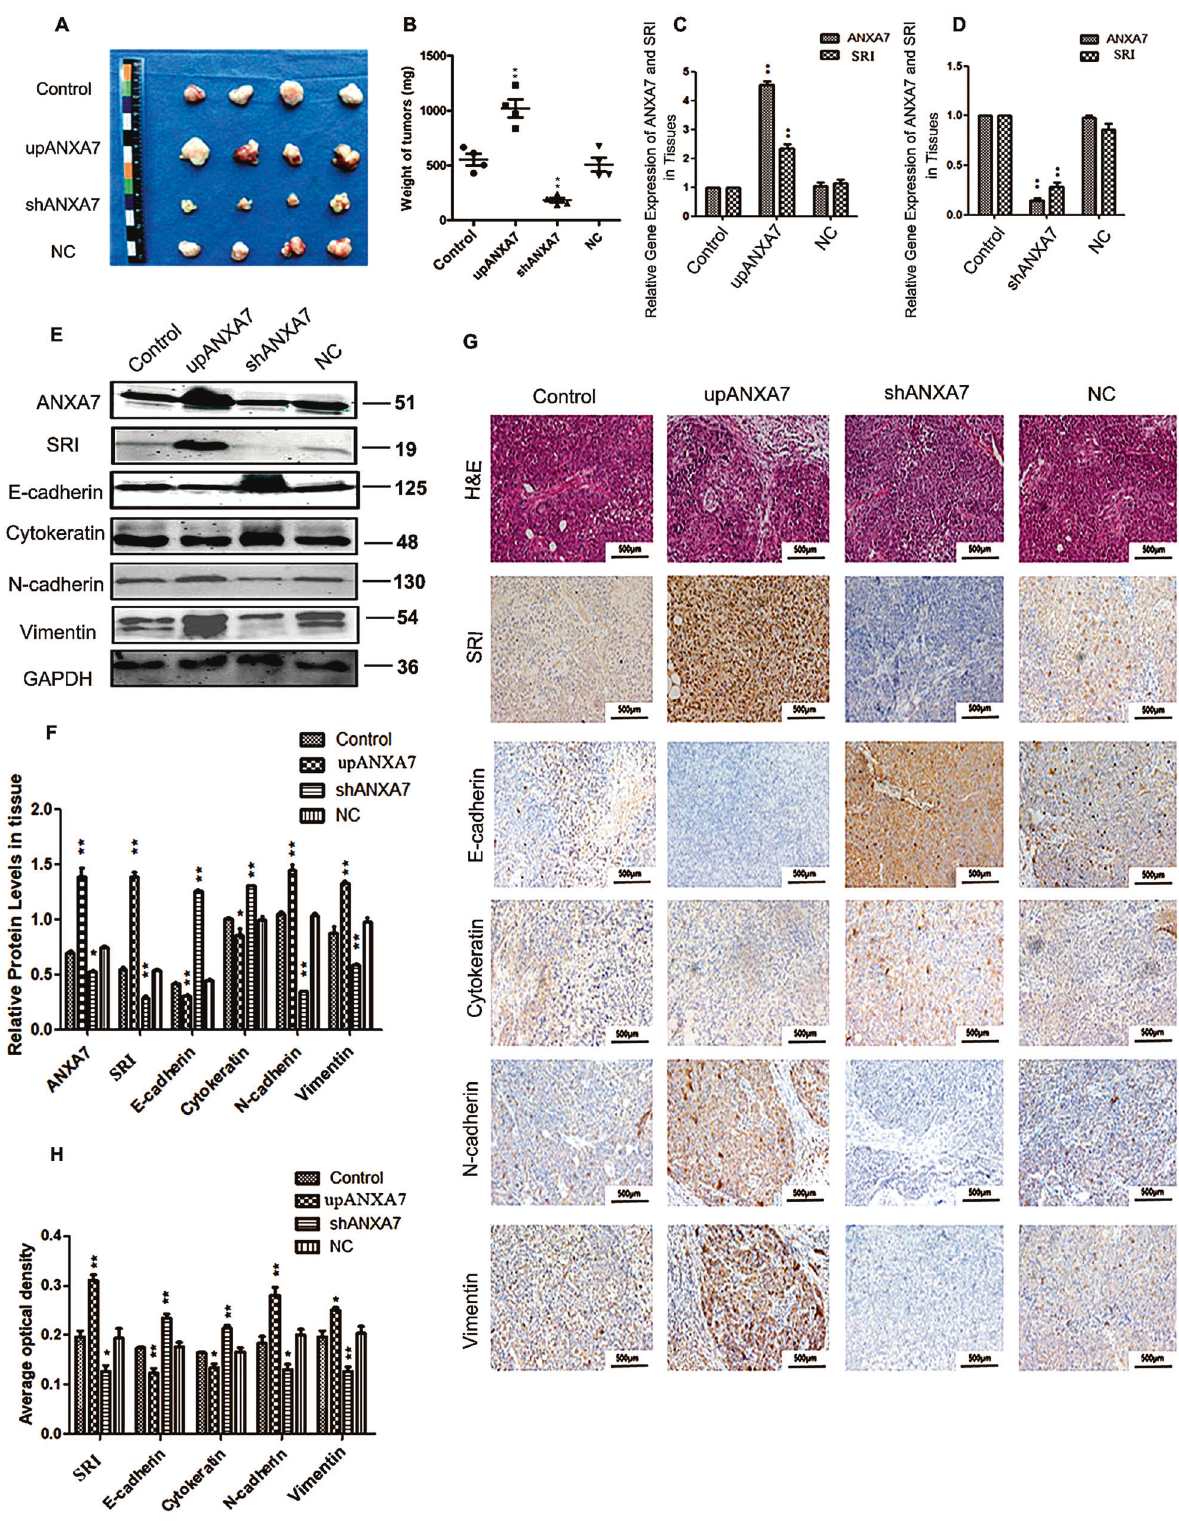
Fig. 5 The effect of ANXA7 on tumorigenicity and EMT in vivo. A , B Images of tumor xenografts and tumor weight (** p < 0.01). C , D The qRT- PCR analysis of ANXA7 and SRI in tumor xenografts (** p < 0.01). E , F Western blotting to detect ANXA7, SRI, E-cadherin, Cytokeratin, N-cadherin, and Vimentin in tumor xenografts (** p < 0.01, * p < 0.05). G , H Immunohistochemical analysis of ANXA7, SRI and EMT indicators in tumor xenografts (** p < 0.01, * p <